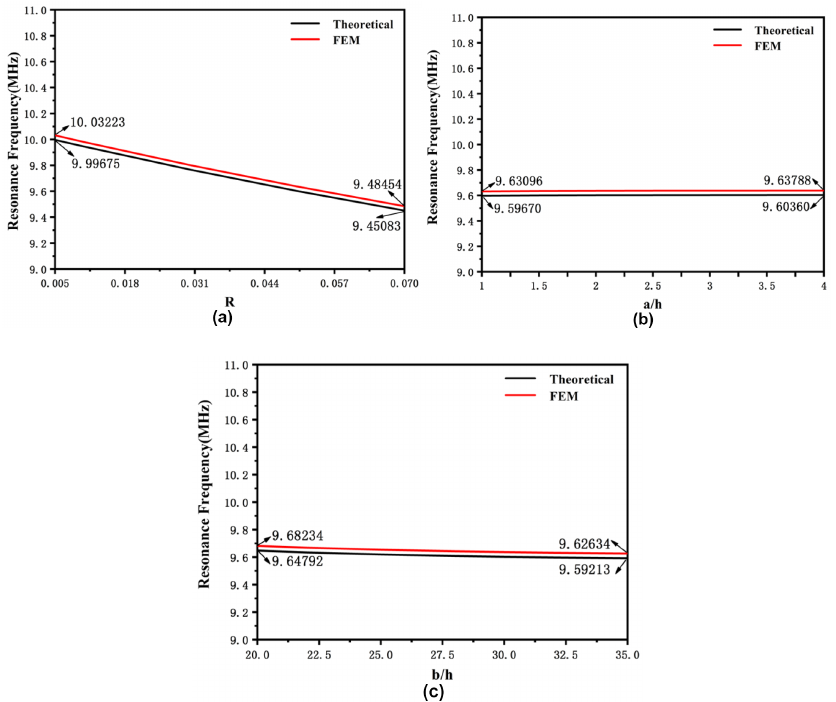
Figure 9. Resonance frequencies of resonators for varied parameters: ( a ) electrode/plate mass ratio R ; ( b ) electrode gap a ; ( c ) electrode width b.